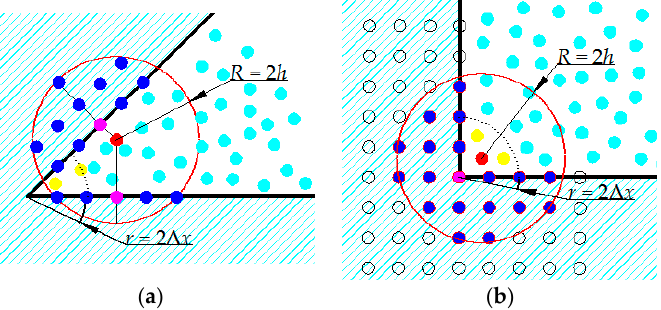
Figure 4. Fictitious particles generation mechanism of the local semi-fixed ghost particles method for a fluid particle around corners. ( a ) r > 2 ∆ x , ( b ) r ≤ 2 ∆ x